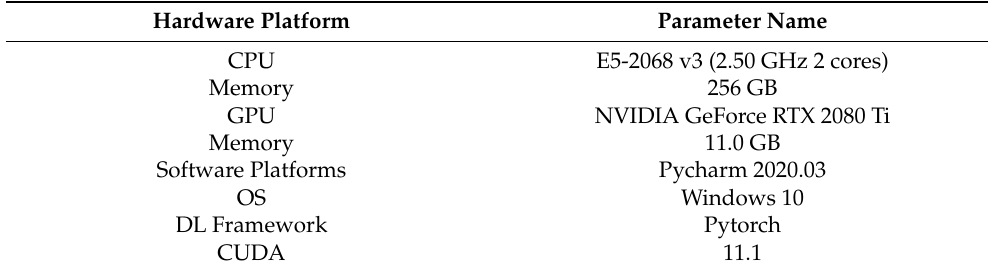
Table 1. Workstation configurations.